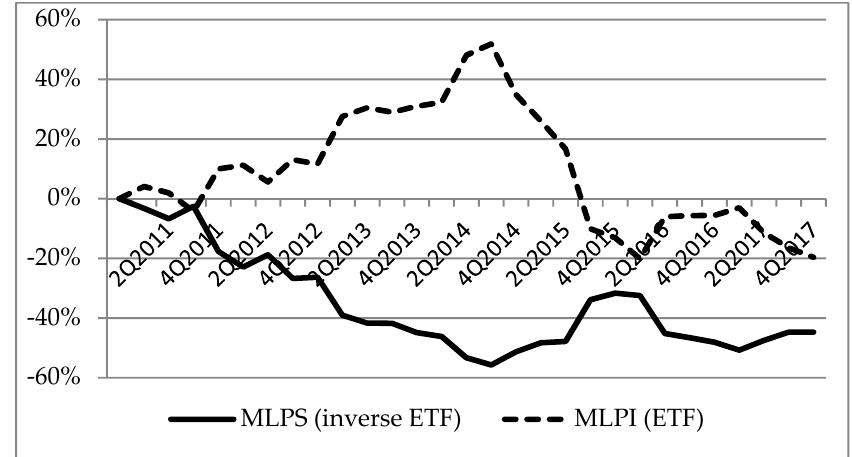
Figure 2. Total return of the exchange-traded fund and inverse exchange-traded fund tracking the same reference index Alerian MLP Infrastructure Total Return Index for the period 2010–2017.